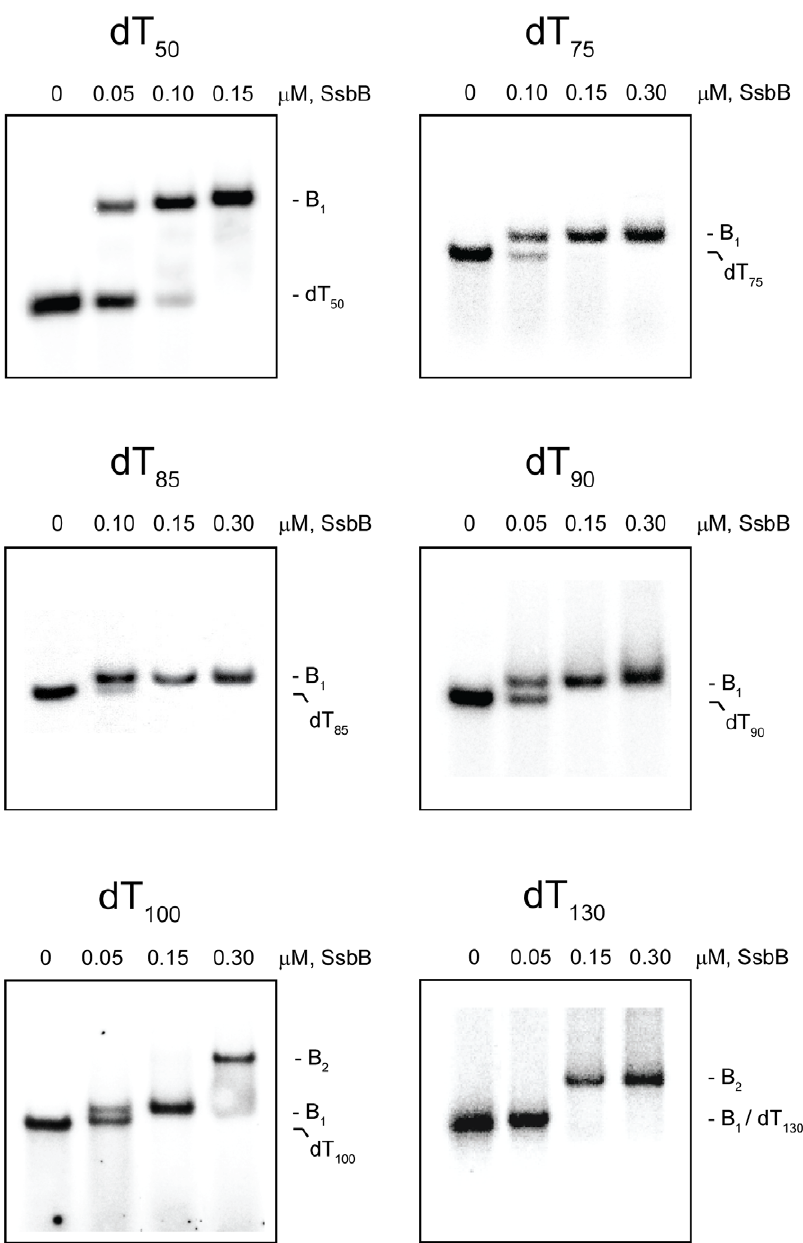
Figure 5. Binding of SsbB protein to dT n oligomers in the presence of Mg 2 + . The reaction solutions contained 25 mM Tris acetate (pH 7.5), 10 mM magnesium acetate, 5 m M dT n (nucleotide concentration), and the indicated concentrations of SsbB protein (tetramer concentrations). The reactions were analyzed by polyacrylamide gel electrophoresis using a gel running buffer consisting of Tris acetate (pH 7.5) and 10 mM magnesium acetate. The bands corresponding to the unbound dT n oligomers, and the B 1 and B 2 complexes, were visualized by phosphorimaging.